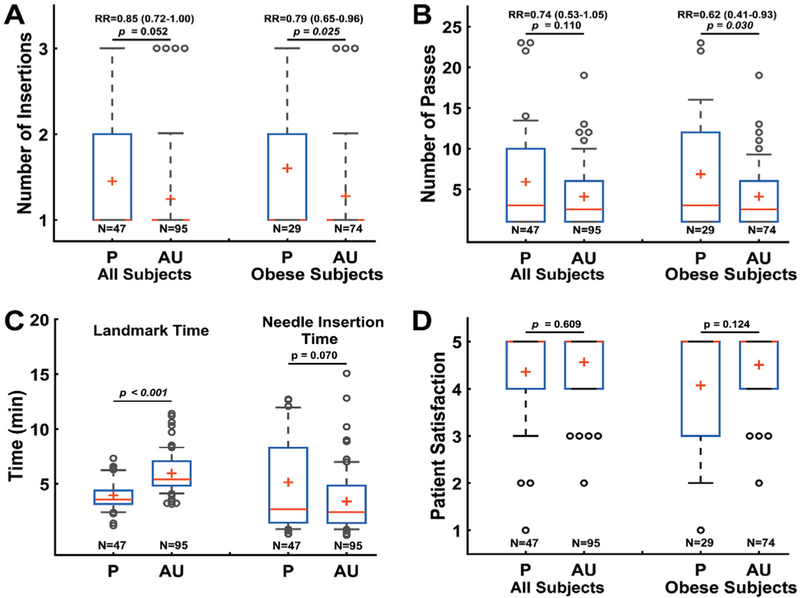
(A) Box plots of needle insertions required for spinal placement across all subjects and obese subjects. (B) Box plots of needle passes required for spinal placement across all subjects and obese subjects. (C) Box plots of time required for landmark identification and needle placement across all subjects. (D) Box plots of patient satisfaction scores across all subjects and obese subjects. In each box plot, the red ‘+’ is the arithmetic mean, the red horizontal line is the median, the extents of the blue box are the 25th and 75th percentile, the whiskers span between 10–90 % of the sample values, and the dots are outliers beyond the 10th and 90th percentiles. Rate ratios (RR) and their significance (p-values) are indicated for each comparison between the P (palpation only) group and AU (all ultrasound) groups. 95% confidence intervals for the value of RR are in parenthesis